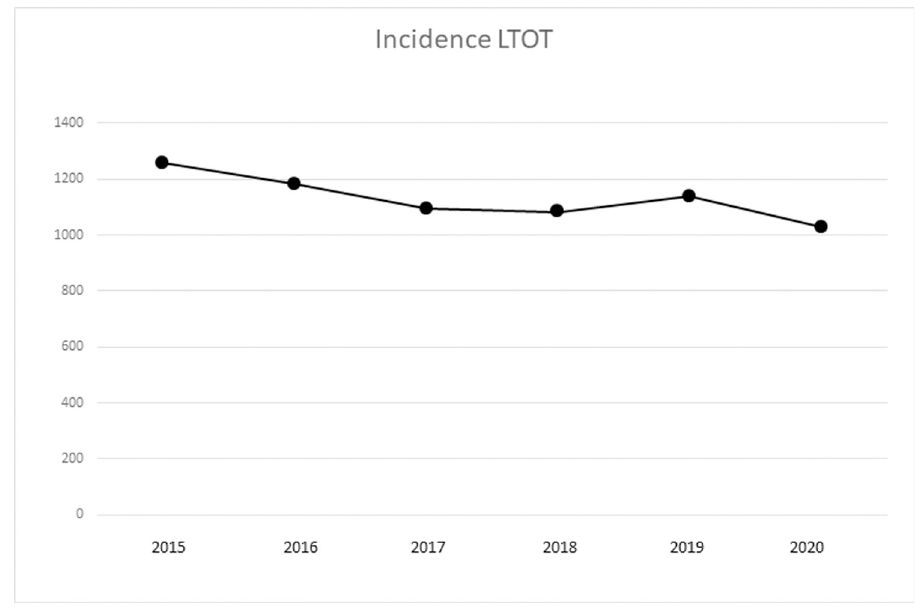
Fig 2. Incidence of LTOT during 2020 compared with the previous 5 years. Incidence of LTOT starts in Sweden per whole year 2015 to 2020. Abbreviations : LTOT = Long Term Oxygen Therapy .